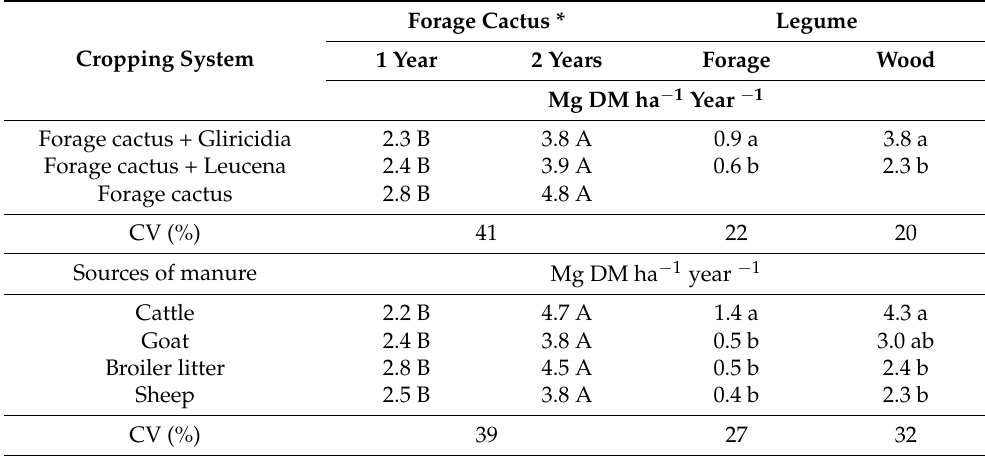
Table 4. Forage cactus and leguminous production in different cropping systems and manure sources.